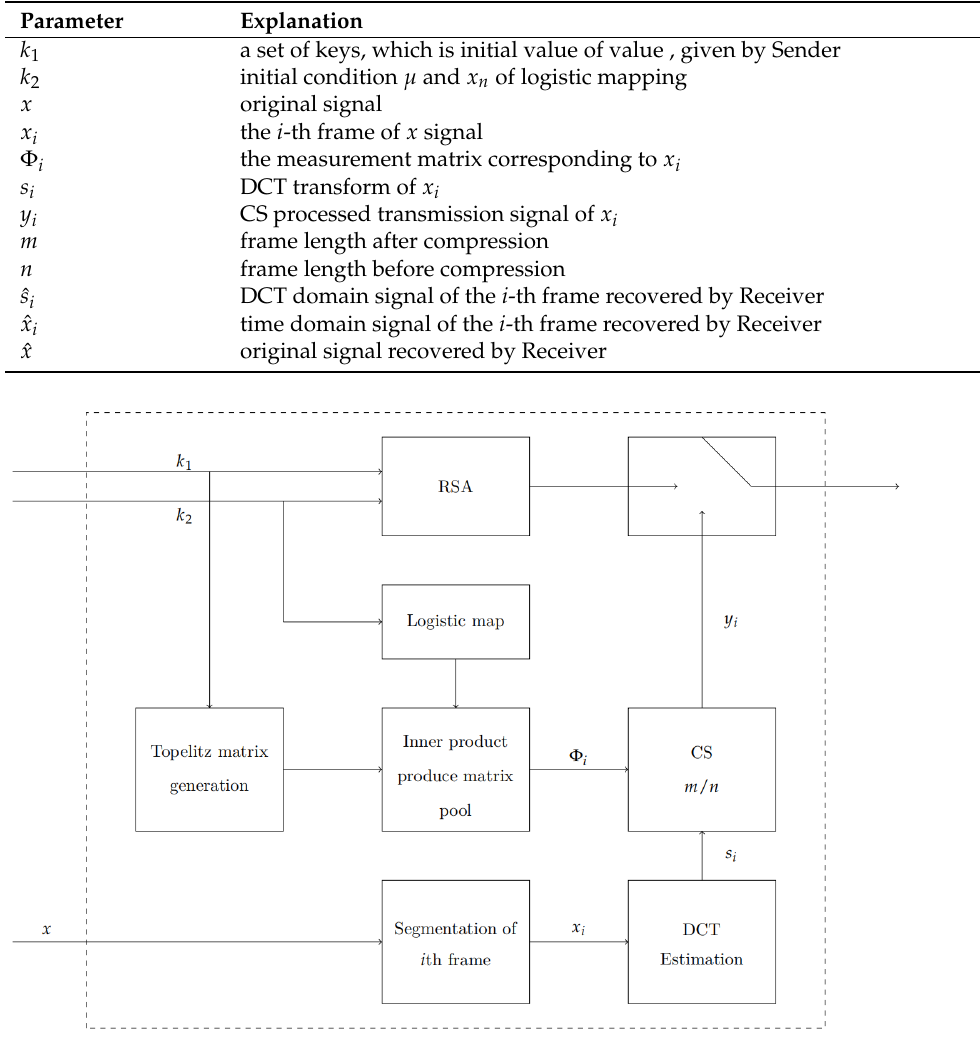
Figure 3. Sender’s compression and encryption